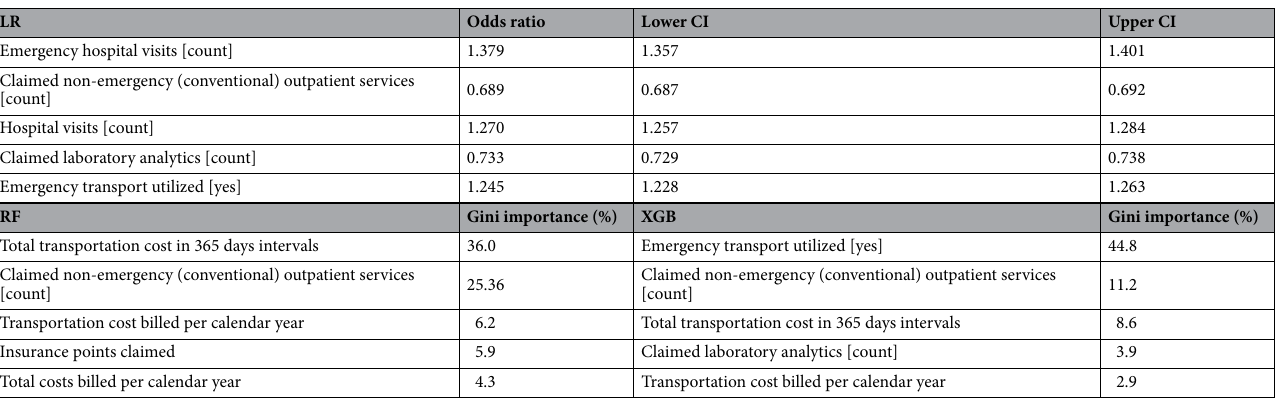
Table 2. The most important predictors used by logistic regression (LR), random forest (RF) and extreme gradient boosting (XGB). For LR, Odds Ratios and 95% confidence intervals (95% CI; from 100 independently trained LR models) are shown to display variable importance, for RF and XGB Gini importance is displayed. Models represented are from dataset with 1 year of follow-up and no time distance to the point of death.